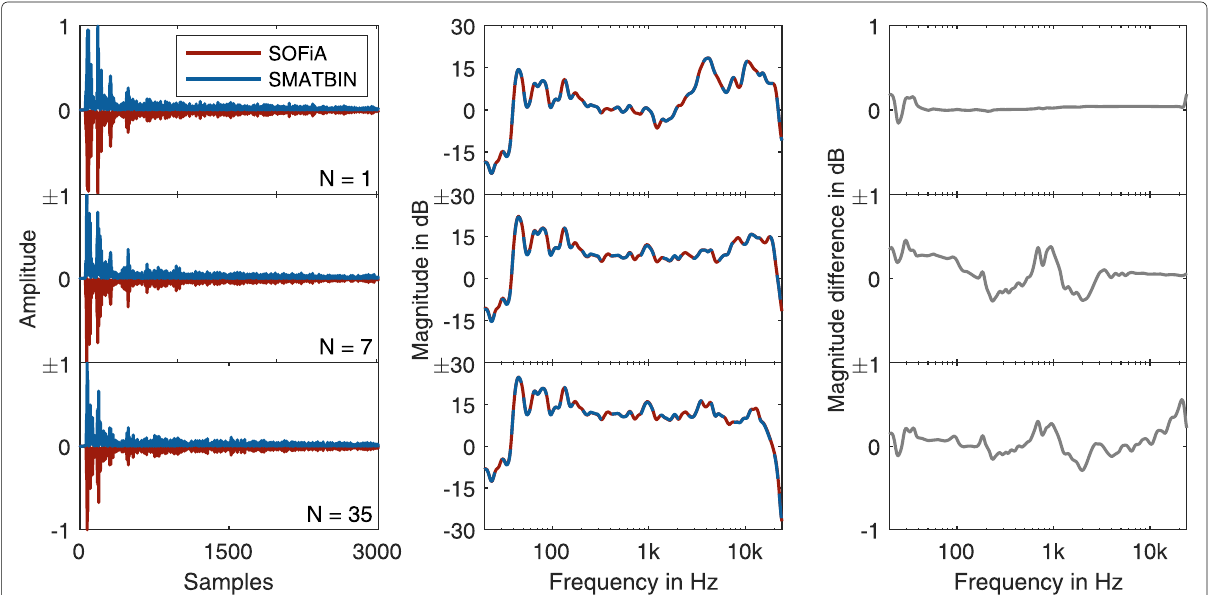
Fig.4 WorkingExample2:Left-earBRIRs/BRTFsresultingfromtheSOFiA(reference)andtheSMATBINfilterprocessing( K =2048taps)forfrontalhead orientation ( φ = 0°, θ = 90°) and impulse responses of a classroom for three different rigid sphere arrays with Lebedev sampling schemes of orders N = { 1,7,35 } . For better illustration, the absolute amplitudes of the SOFiA BRIRs in the left column are inverted and the magnitudes of the BRTFs in the middle column are 1/6-octave smoothed. The right column shows the magnitude differences between the SOFiA and the SMATBIN